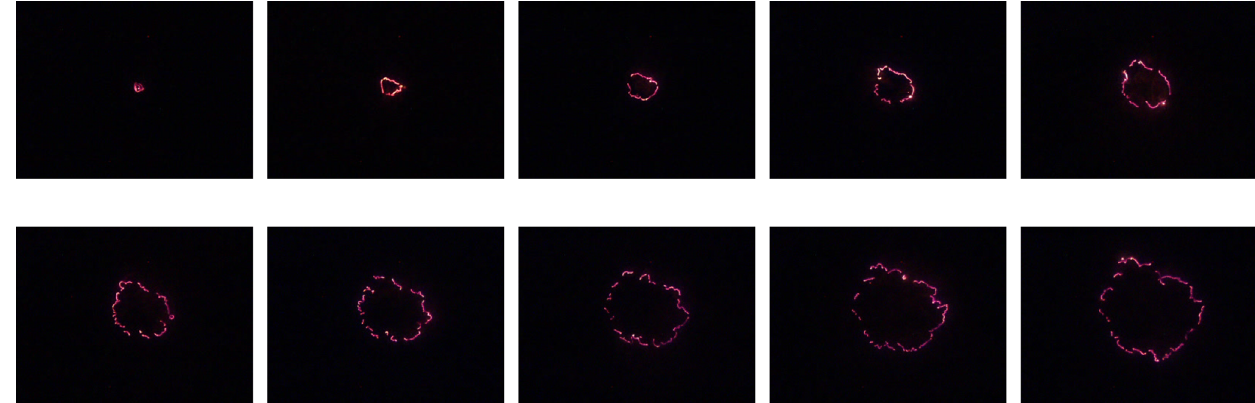
Figure 1. A sequence of burn patterns on a sheet of wax paper observed at times of 1, 6, 11, 16, 21, 26, 31, 36, 41, and 46s for the third microfire. Time increases from left to right, and then down.